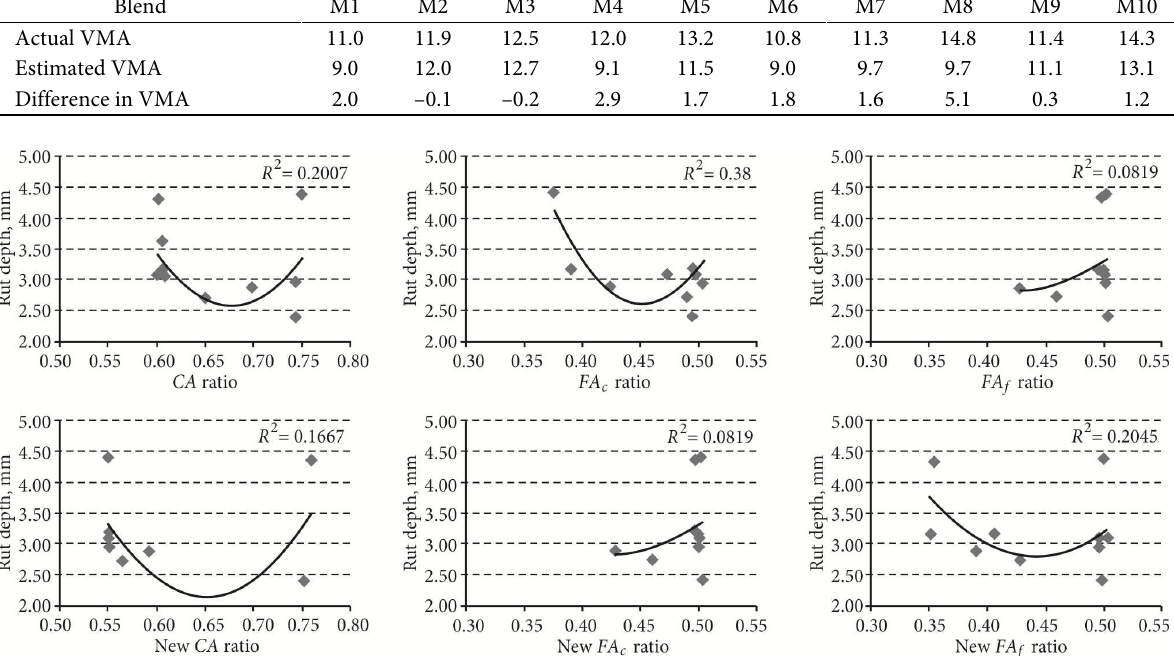
Fig. 4. The Bailey ratios versus rut depths